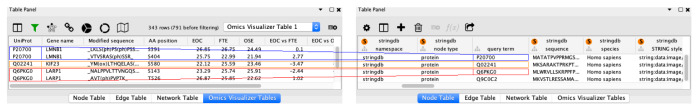
An Omics Visualizer table (left) and a node table (right) from a STRING network.Both tables can be linked together using the key column ‘UniProt’ from the Omics Visualizer table with the key column ‘query term’ from the node table. The color boxes identify the key values used to link the two tables, the color lines emphasize the link between the rows of the two tables.